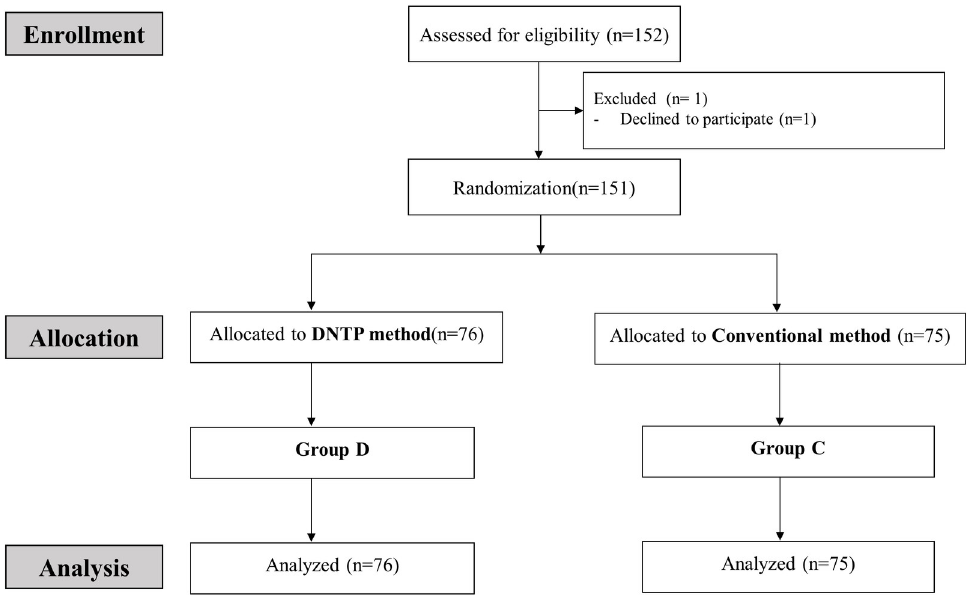
Fig 2. CONSORT flow